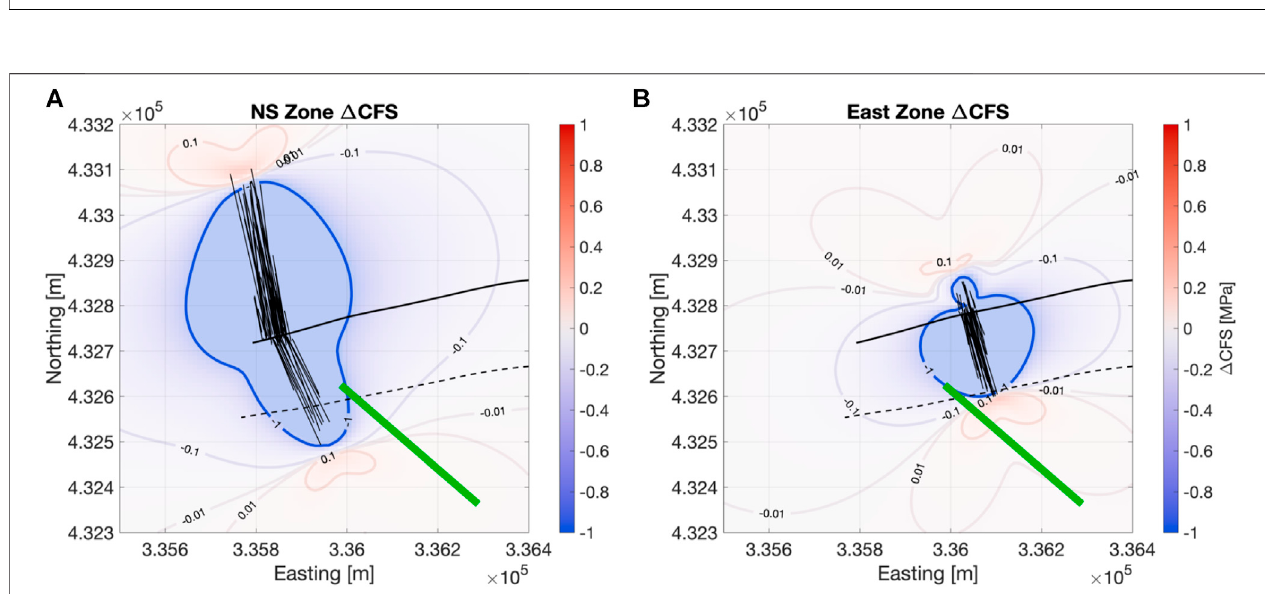
FIGURE5| Examples ofthestochasticallygeneratedhydraulicfracture “ sources ” usedtosimulate stresschangesinthesurrounding rocks.In (A) weshow amap view of the sources for the NS Zone (blue lines) and the Eastern Zone (red lines) with the observed microseismicity overlain (grey dots). The well paths are shown by the solidblacklineforPNR-2,andthedashedblacklineforPNR-1z.ThelocationsoftheinjectionpointsduringPNR-2operationsareshownbythegreydiamonds.In (B) we show a 3D view of the model hydraulic fracture